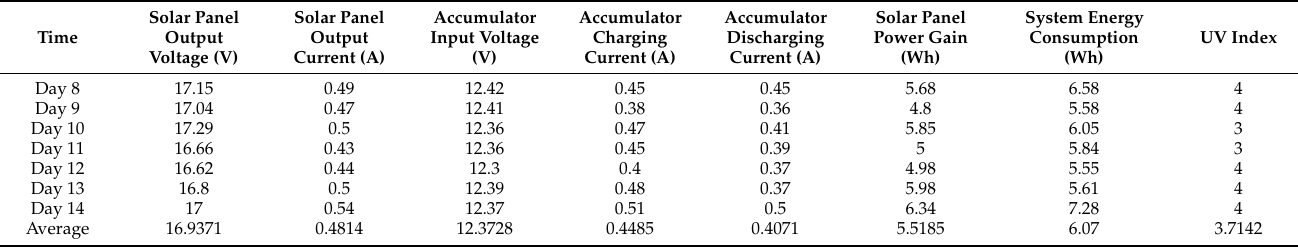
Figure 4. Global Energy Production of the Solar Tracking Device for the Mostly Sunny Week. Table 3. Experimental results regarding Solar Panel Energy Generation and Storage, as well as System Energy Consumption during the Partly Cloudy Week